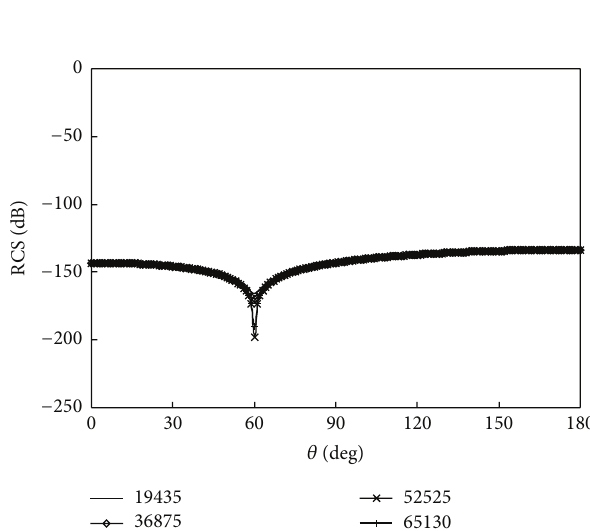
Figure 1: The sketch of the octree structure.